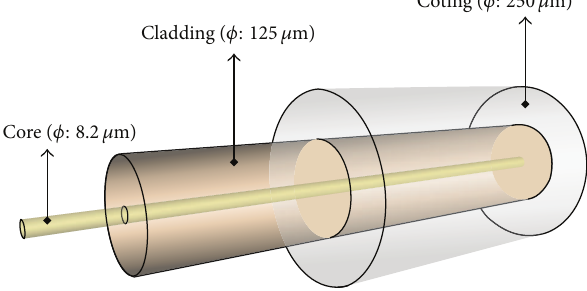
Figure 2: Single-mode optical